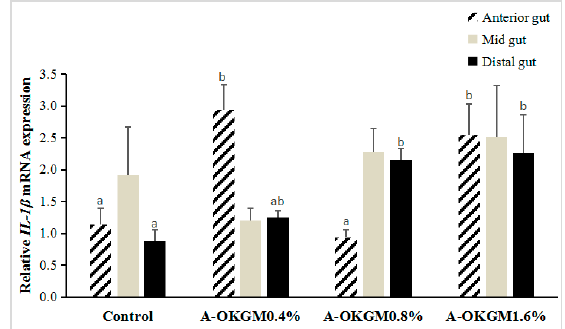
Figure 3. Effects of A-OKGM on IL-1 β expression in the anterior, mid- and distal gut of Schizothorax prenanti . The observed values are expressed as the mean ± S.E. a,b Means with different superscripts are significantly ( p < 0.05) different from each other.